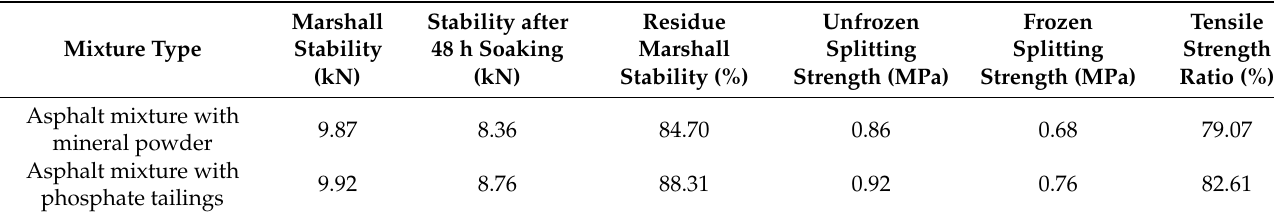
Table 4. Results from Marshall test and freeze–thaw split